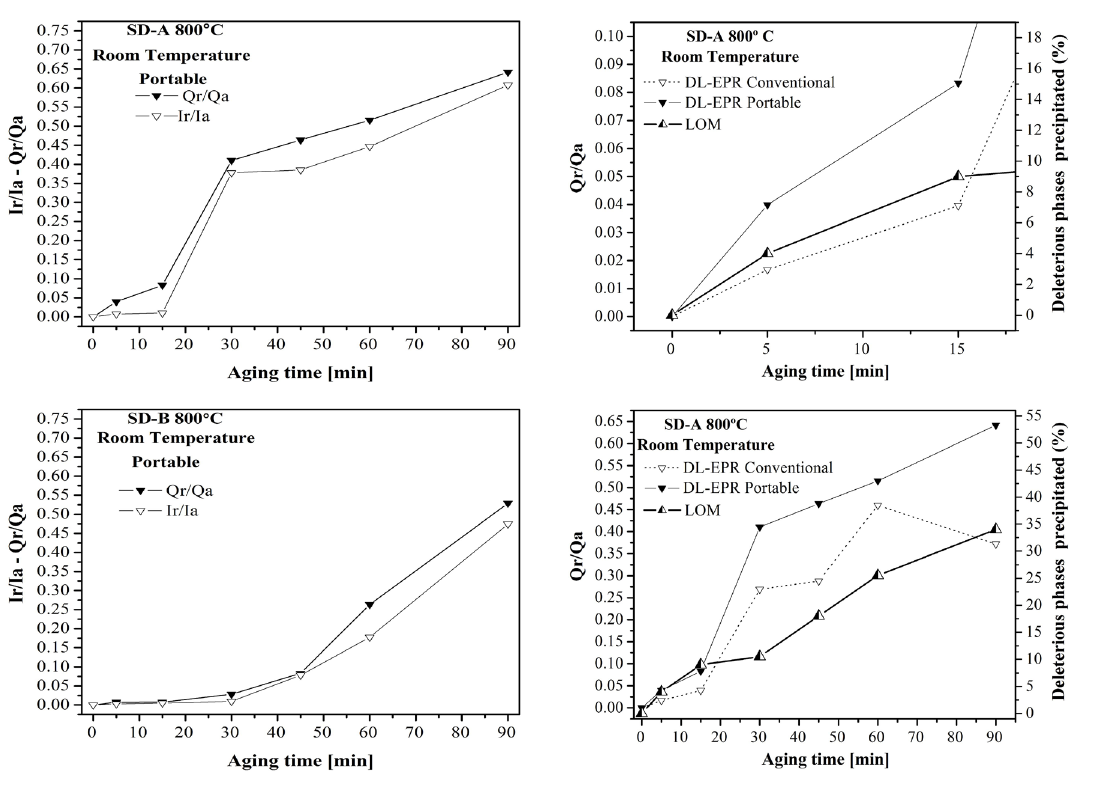
Figure 5. Ir/Ia and Qr/Qa ratio values in portable DL-EPR tests at room temperature in the samples (a) SD-A and (b) SD-B aged at 800ºC.